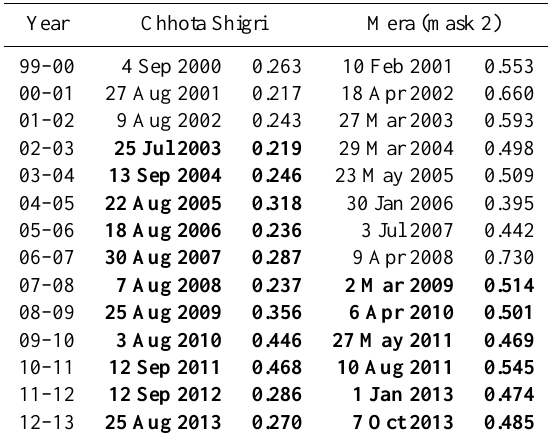
Table 3. Values of the observed minima of the mean albedo and dates at which they are observed. At Mera Glacier, minimum albedo dates can occur between 1 August and 30 June of the following year. The data used for the calibration are in